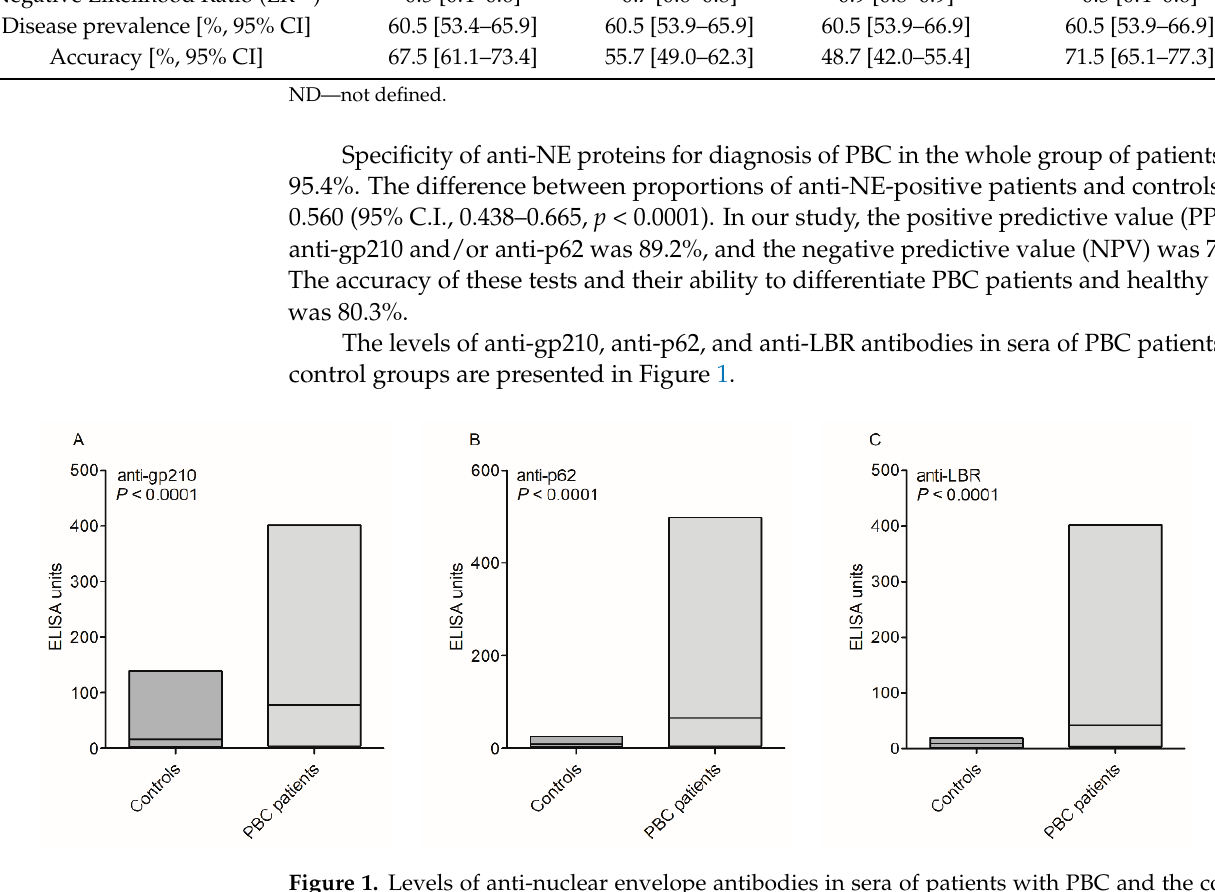
Figure 1. Levels of anti-nuclear envelope antibodies in sera of patients with PBC and the control group: ( A ) anti-gp210, ( B ) anti-p62, ( C ) anti-LBR.